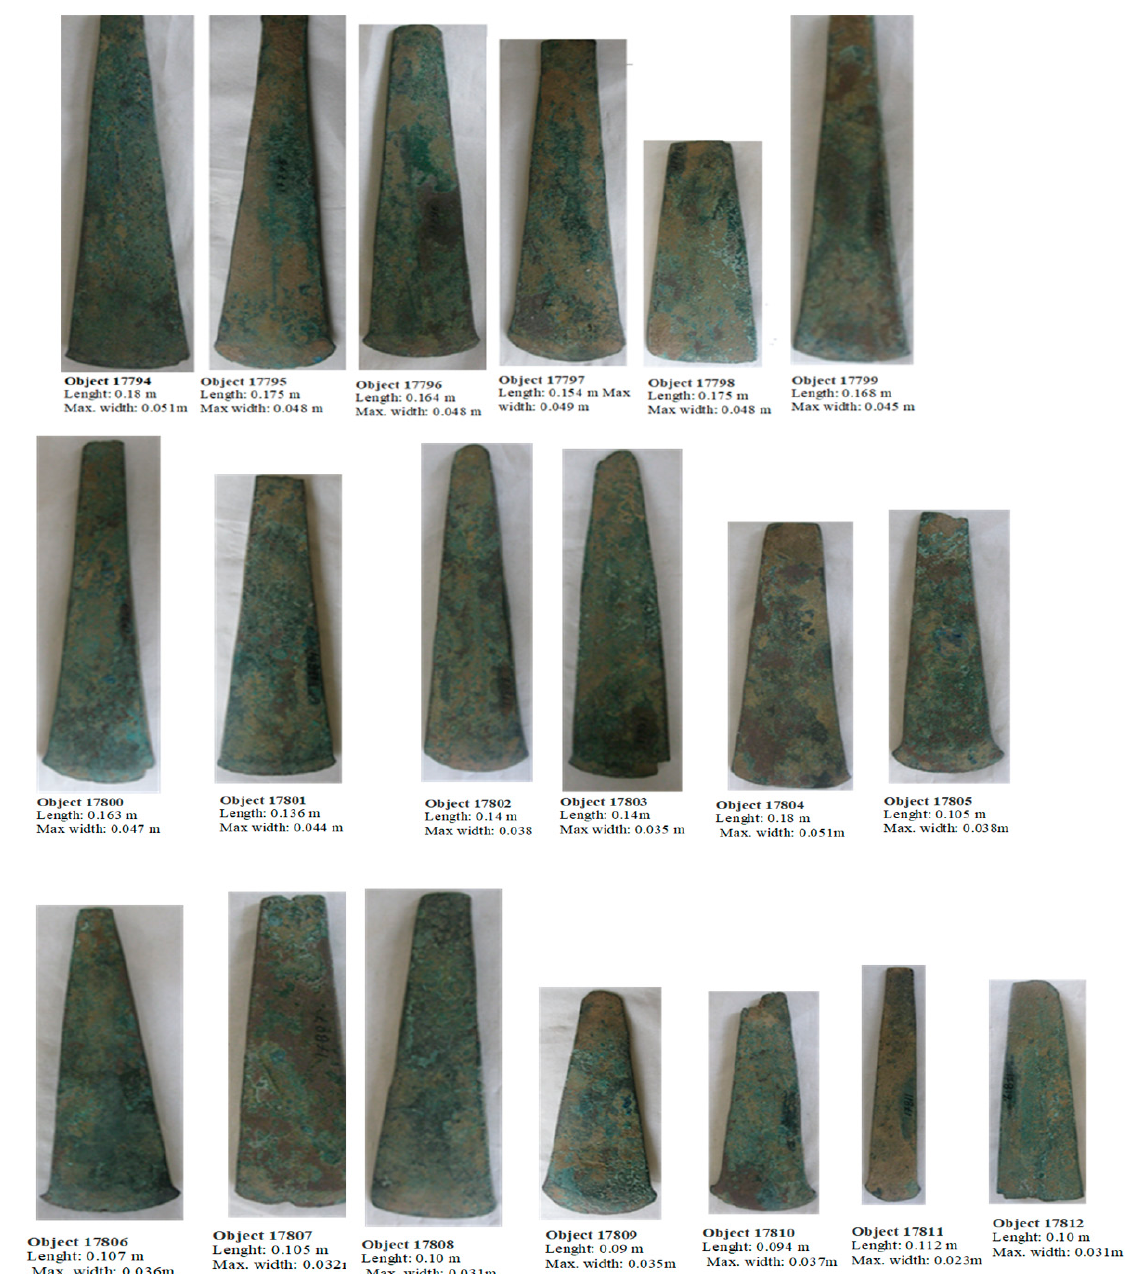
Figure 1. 19 Chisels originated from Macedonia, Chalkidiki, Petralona, and dated at the Early Bronze Age (2700–2300 BC) —Nos. 17794–17812.